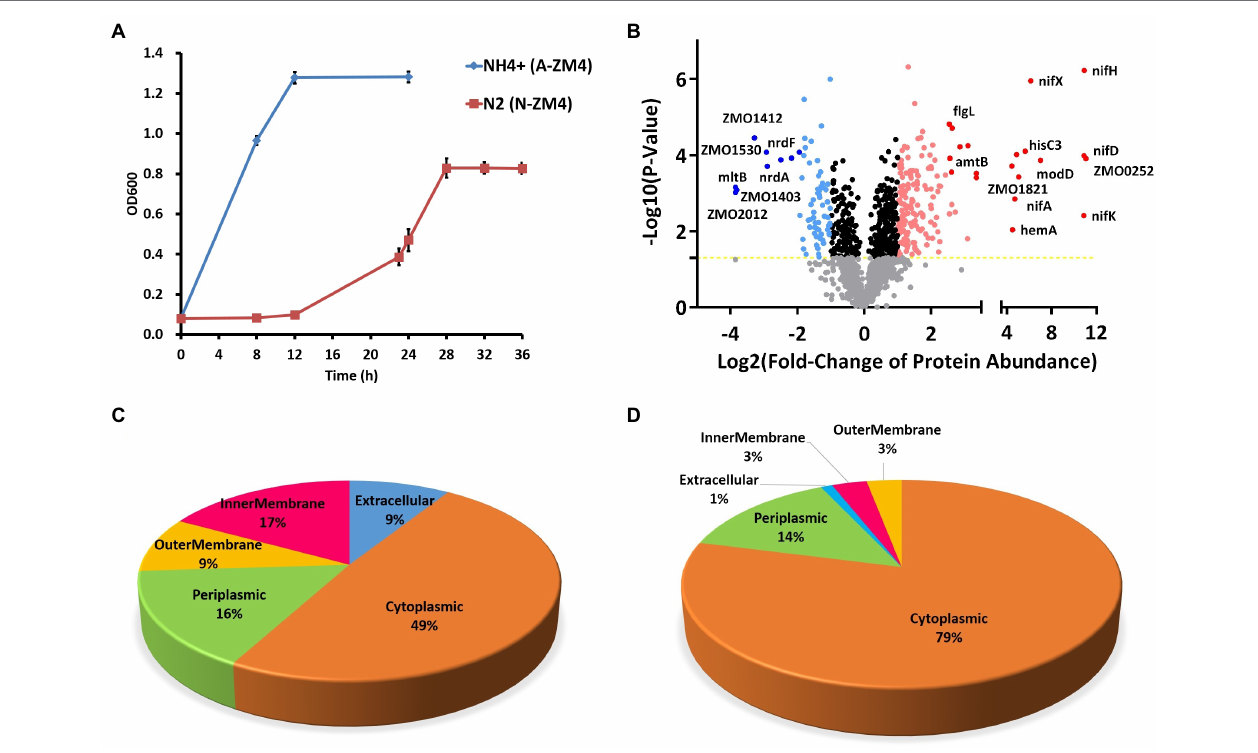
FIGURE 1 | Proteomics analyses of Zymomonas mobilis under N 2 -fixing conditions. (A) Growth of Z. mobilis under the nitrogen-fixing (red) and non-fixing (blue) conditions. (B) Differential protein expression under N 2 -fixing conditions. Protein names are shown for some highly differentially expressed proteins. (C) Subcellular localization of upregulated proteins. (D) Subcellular localization of downregulated